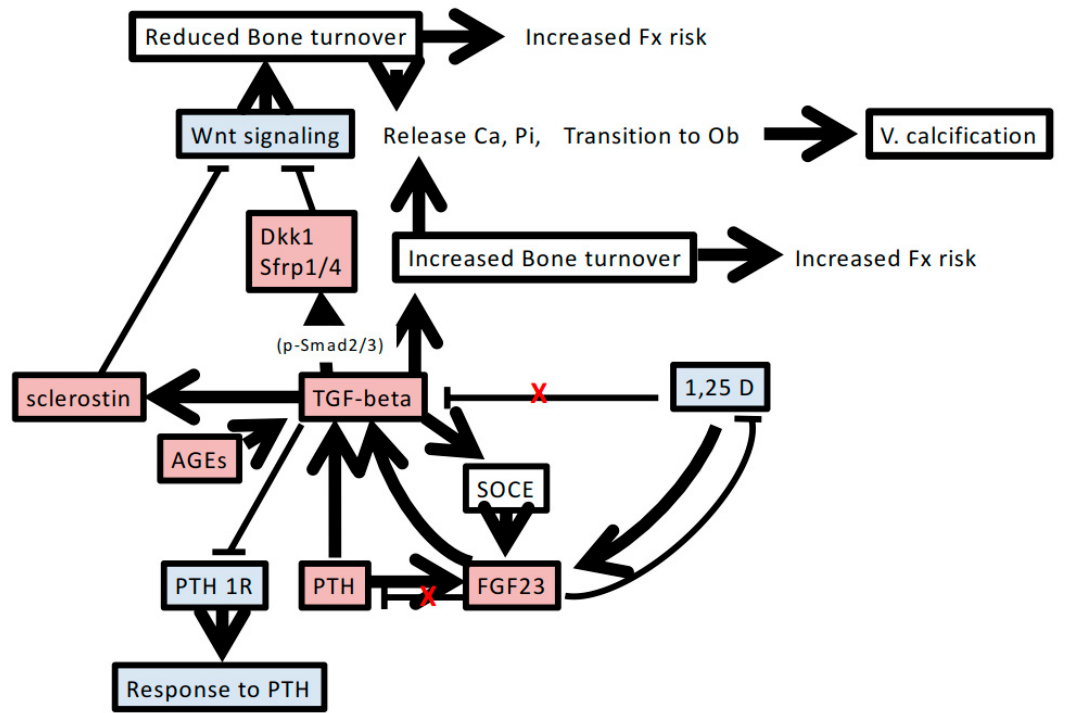
Figure 1. Possible factors and pathways associated with the involvement of TGF- β in chronic kidney disease-mineral and bone disorder. Increasing TGF- β levels accompanied by renal dysfunction induces mineral metabolism disturbance and bone remodeling. The detailed mechanisms and interactions are described in the text. Red-shaded boxes indicate increased levels of factors or phenomena. Blue-shaded boxes indicate decreased levels of factors. Red X indicates regulatory disturbance in chronic kidney disease. T bar indicates inhibitory action of humoral factor. FGF23, fibroblast growth factor 23; PTH, parathyroid hormone; PTH1R, PTH type 1 receptor; 1,25D, 1,25 dihydroxyvitamin D 3 ; AGEs, advanced glycation end products; Dkk1, Dickkopf-1; V. calcification, vascular calcification; Ob, osteoblasts; Ca, calcium; Pi, phosphorus; SOCE, store-operated calcium entry; Fx, fracture.